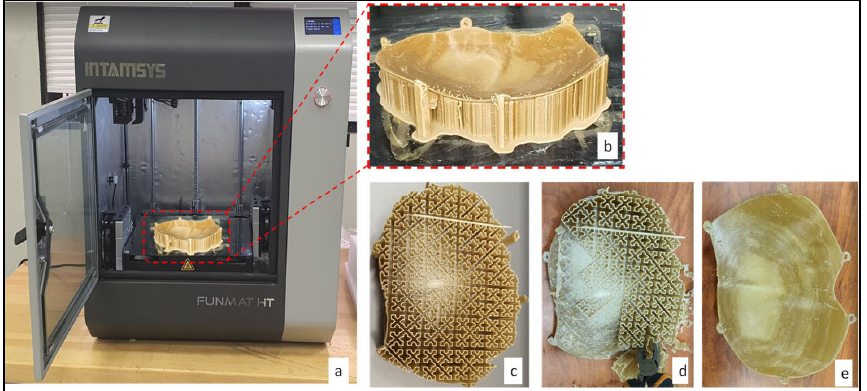
Figure 6. ( a ) Intamsys 3D Printer used in the fabrication of the customized ( b ) PEEK cranial Implant; ( c ) Support structures bottom view; ( d ) removal of the supports using plyers; ( e ) the PEEK cranial implant after the supports’ removal. Table 3. Process parameters in the fabrication of the PEEK implant using the FUNMAT HT printer.